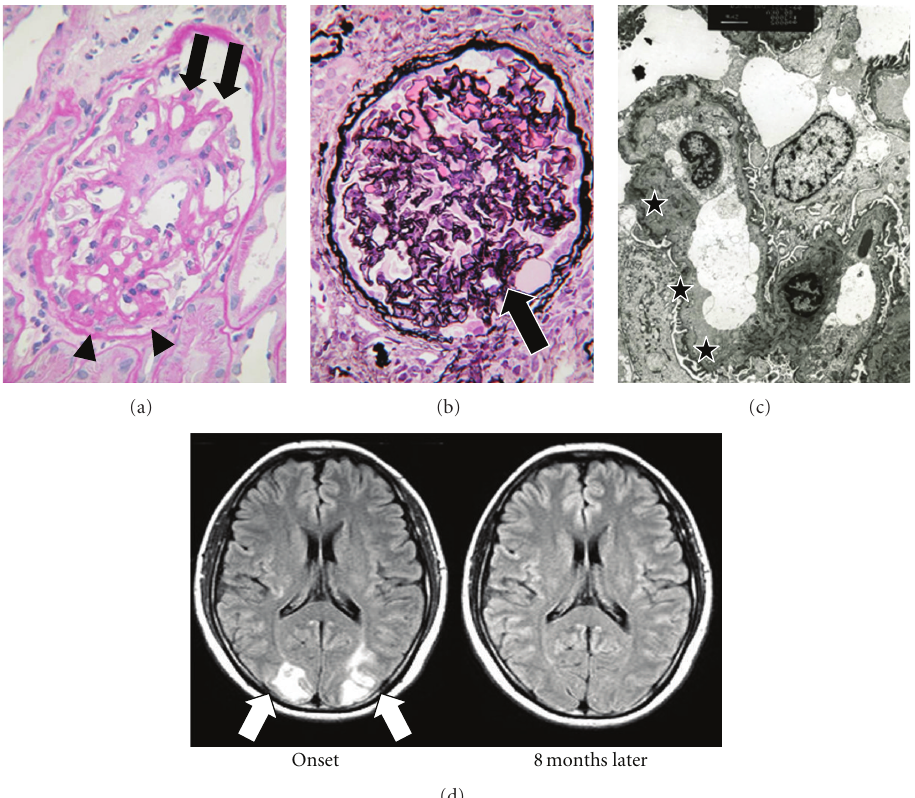
Figure 2: (a, b): A 40-year-old patient delivered a 736g baby at 27 gestational weeks. Serum creatinine level was 2.06mg/dl at 5 months after delivery. (a) A glomerulus shows segmental sclerosis and adhesion to Bowman’s capsule (arrowheads). Glomerular capillary wall is thickened with double contour (arrows). (PAS, × 400). (b) A collapsing glomerulus revealing focal segmental sclerosis (arrow) with fibrinous exudate (PAS-methenamine silver, × 400). (c) A 41-year-old patient delivered a 2372g baby at 37 weeks. Proteinuria prolonged for 9 months after delivery. Upon electron microscopy, subendothelial edema is observed (stars) ( × 3,000). (d) Di ff usion abnormalities in a 32-year-old preeclamptic woman with RPLS. She complained of a headache from the beginning of labor at 37 weeks and lost her consciousness. Blood pressure was 181mmHg and proteinuria was 8,900mg/day. MRI illustrates the lesion of posterior lobes at the onset of convulsion (left, arrows). She recovered consciousness in a week, and the lesion diminished completely in 8 months after delivery